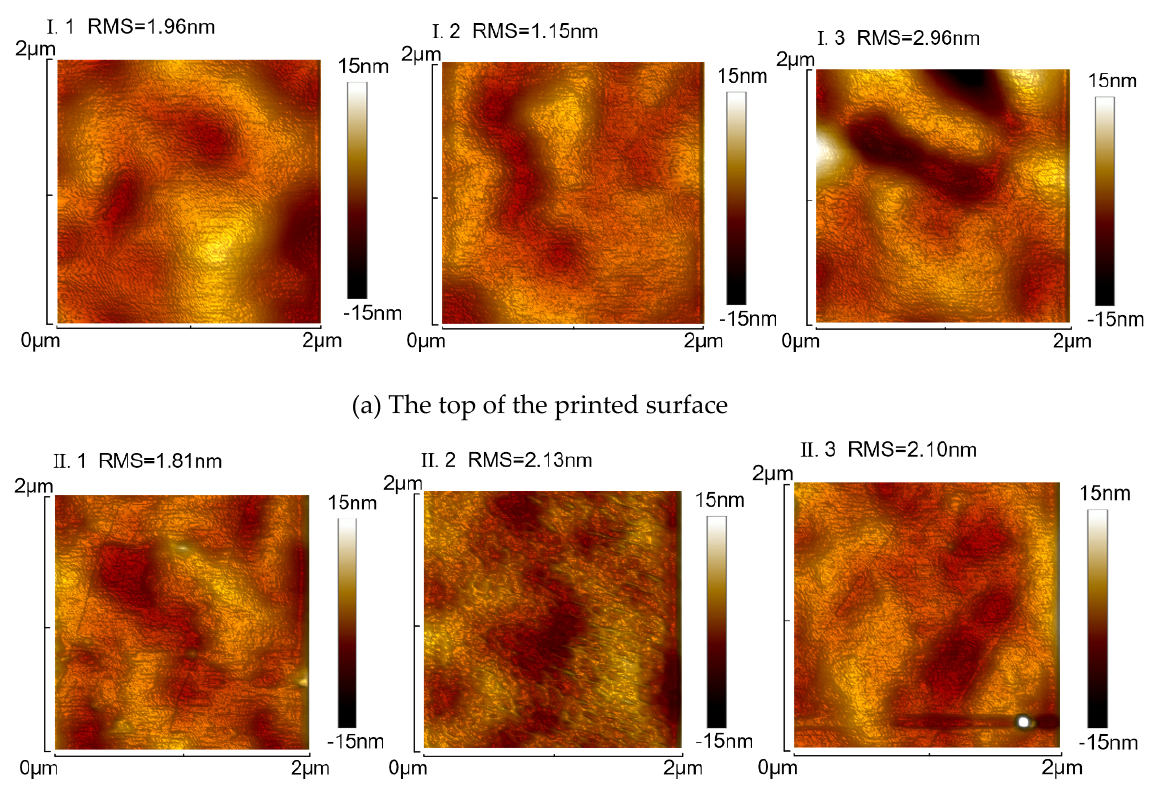
Figure 9. AFM measured surface roughness (2 × 2 µ m sampling) on the smoothed DentaClear lens: ( a ) sampling area I on the top surface and ( b ) sampling area II on the side surface.